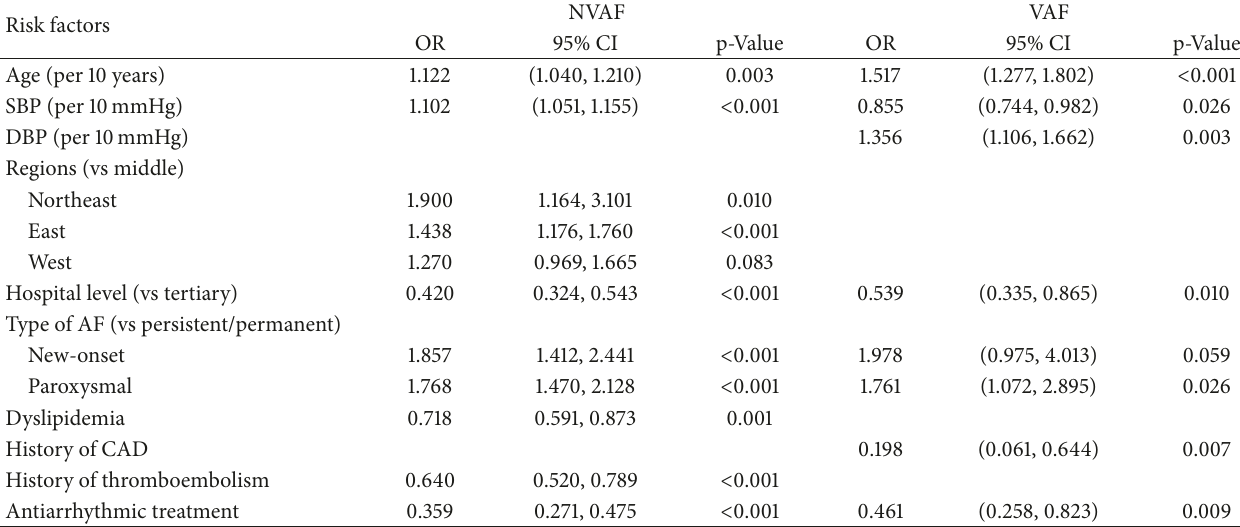
Table 2: Risk factors for underuse of anticoagulants in patients with moderate-to-high risk NVAF and patients with VAF. Risk factors